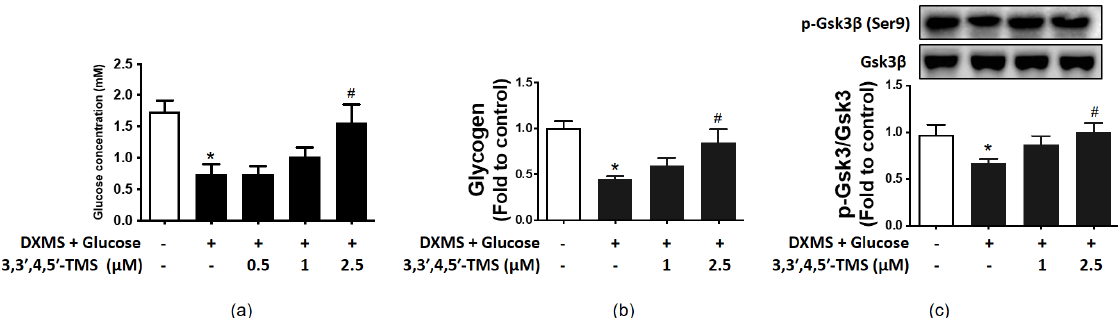
Figure 2. The effects of 3,3′,4,5′-TMS on glucose consumption of insulin-resistant HepG2 cells (IR- HepG2 cells). ( a ) Glucose consumption, ( b ) glycogen content and ( c ) phosphorylation of Gsk3β at Ser9 in IR-HepG2 cells pre-treated with high glucose (50 mM) plus DXMS (30 µM) for 48 h and treated with 3,3′,4,5′-TMS for another 16 h. Values are the means ± SEM ( n = 3); * p < 0.05 vs. Control; # p < 0.05 vs. DXMS + glucose.